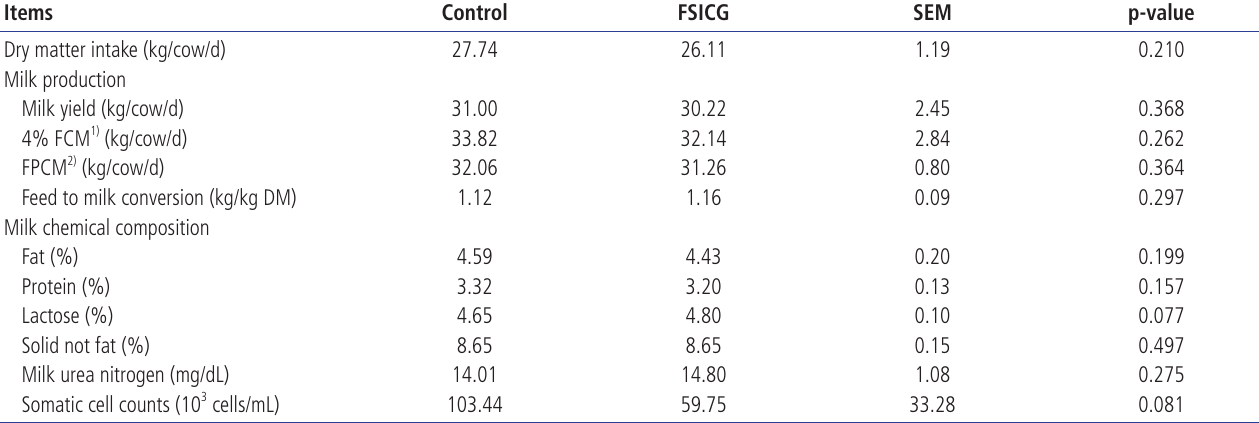
Table 6. Dry matter intake, milk production and composition of fermented spent instant coffee ground feeding trial in lactating dairy cows Items